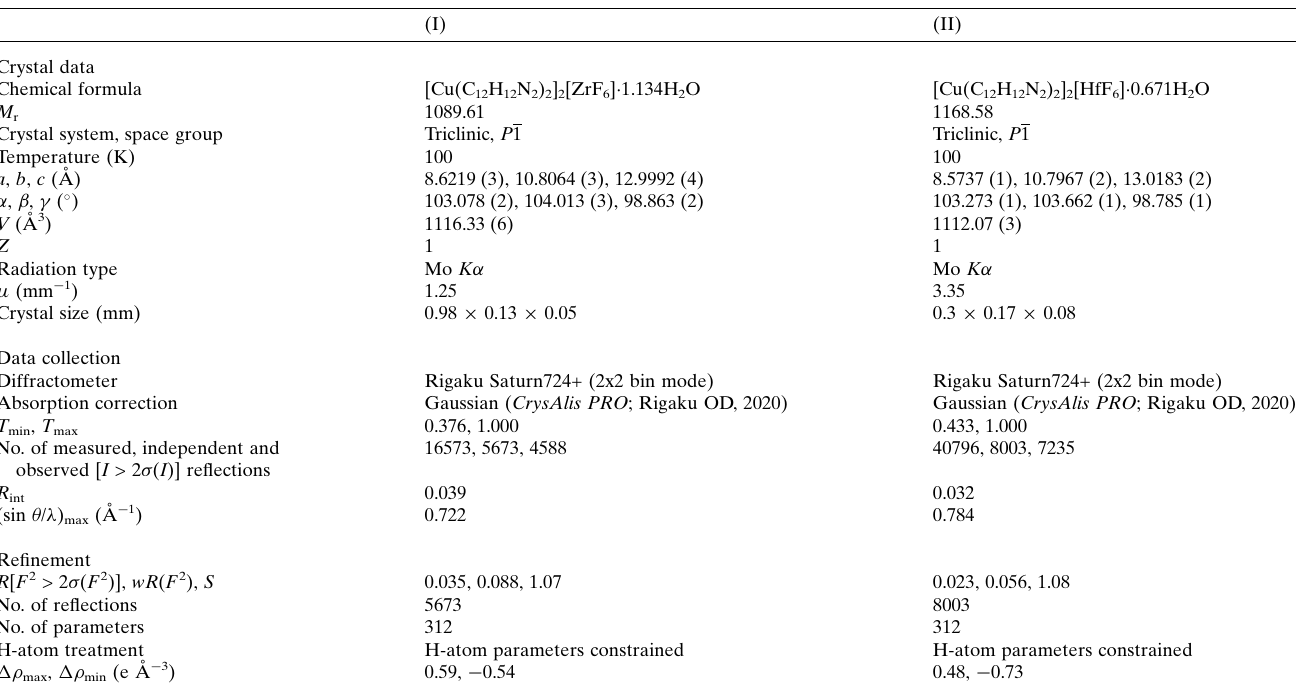
Table 7 Experimental